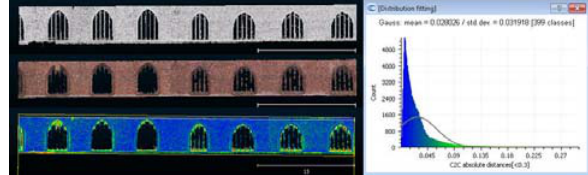
Figure 9. TLS DOM, UAS DSM and differences of distances between them as map and as histogram.